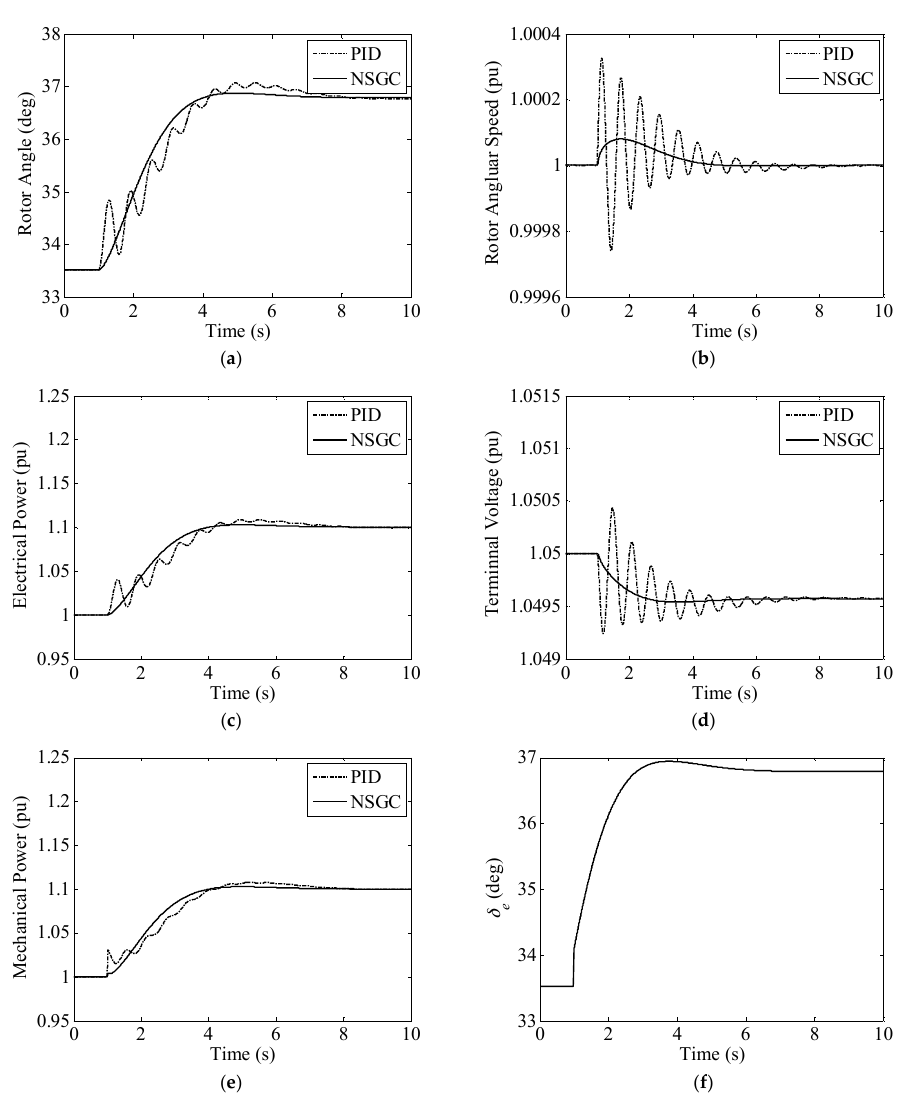
Figure 6. Responses to a step change of the mechanical power. ( a ) Rotor angle response; ( b ) Rotor angular speed response; ( c ) Electrical power response; ( d )Terminal voltage response; ( e ) Mechanical power response; ( f ) Reference change of the rotor angle.